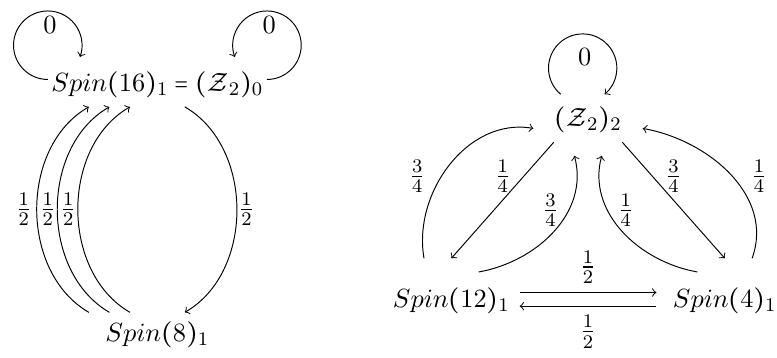
Figure 1: The fractionalization maps of (cid:90) arrow labels the spin of the (cid:90)